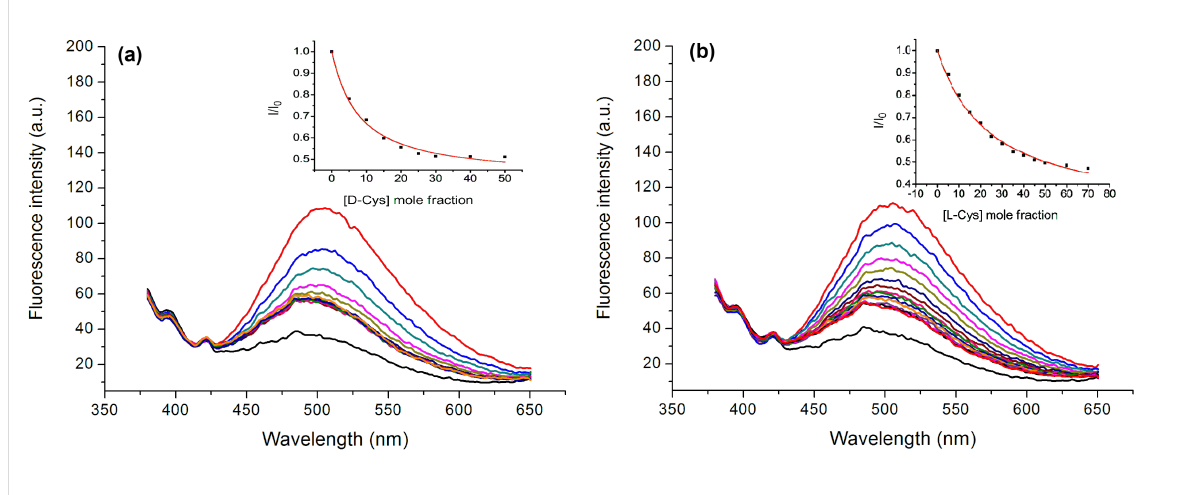
Figure 5: Fluorescence spectra of Cd 2+ –ACAQ (10 µm) upon the titration of (a) D-Cys and (b) L-Cys in buffer solution (10 µM, HEPES, 1% ACN, pH 7.4 ) at 298 K with λ ex = 350 nm. Inset is the titration data point and the nonlinear least-squares fitting curve at 500 nm.